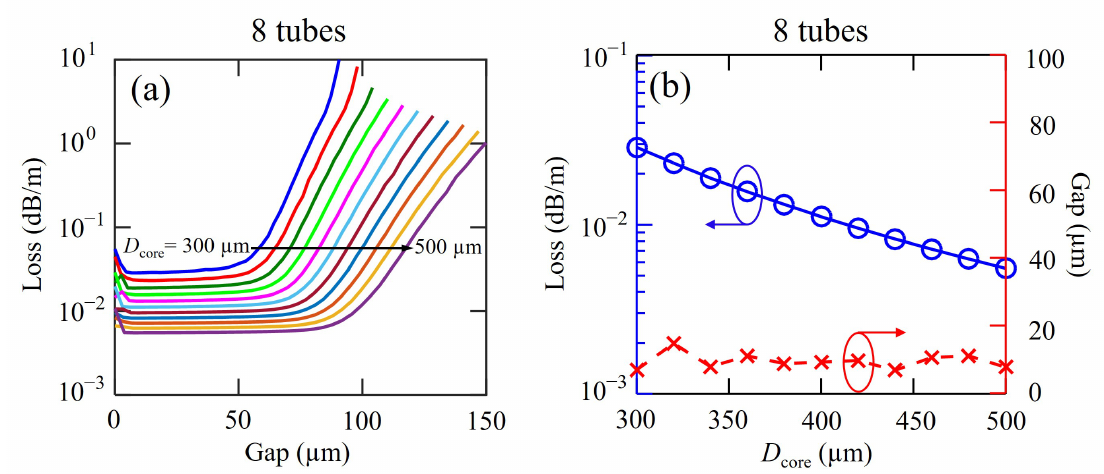
Figure 8. ( a ) Loss as a function of gap in fibers with different core diameters. ( b ) Minimum loss and corresponding gap in fibers with different core diameters. The number of cladding tube is